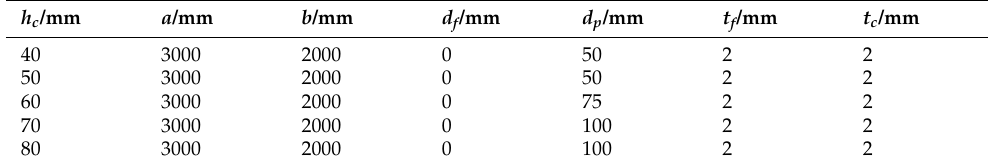
Table 8. Geometric parameters of the V-type corrugated sandwich panel with different core heights.